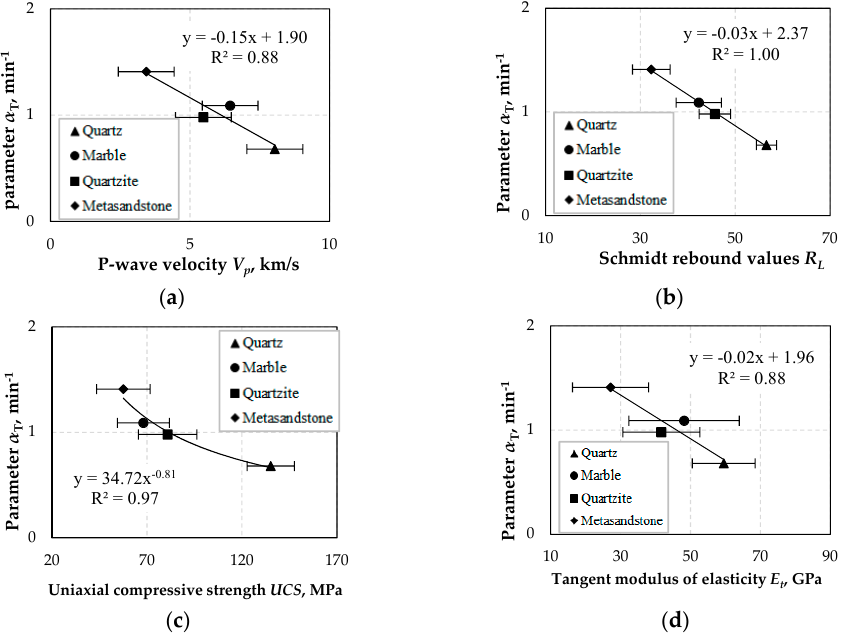
Figure 11. Correlations between parameter α T and ( a ) P-wave velocity V p , ( b ) Schmidt rebound values R L , ( c ) uniaxial compressive strength UCS and ( d ) tangent modulus of elasticity E t ; horizontal error bars show standard deviation of the measurements.